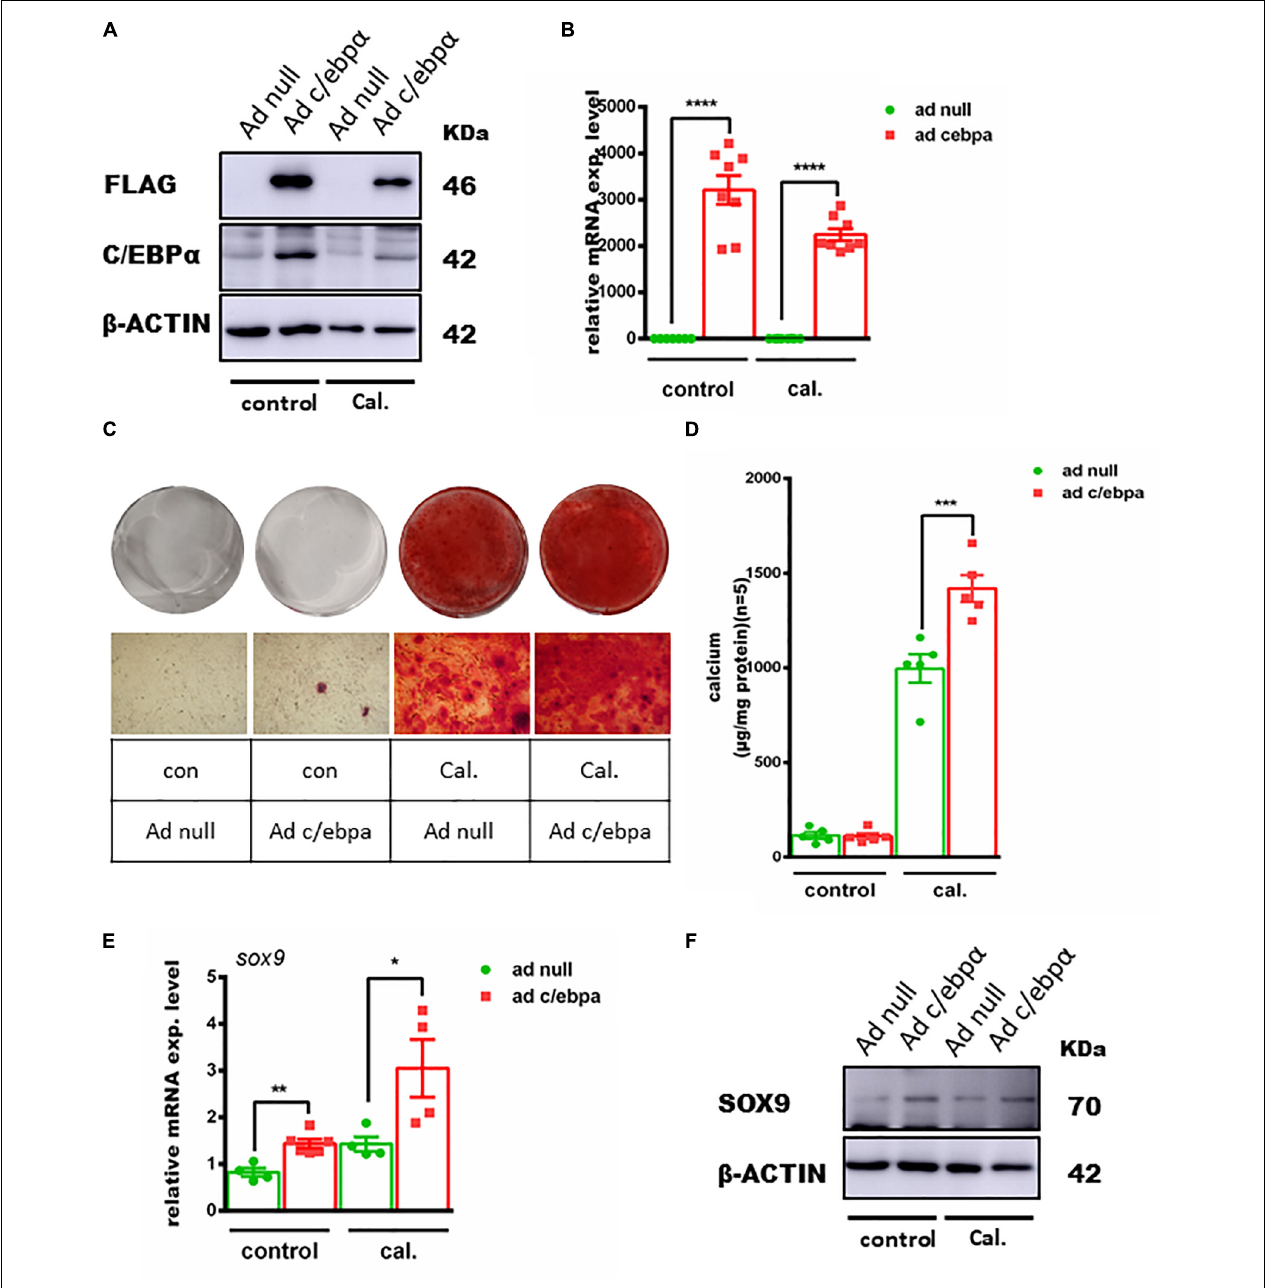
FIGURE 4 | Overexpression of the c/ebp α enhanced calcium-/phosphate-induced VC through upregulating SOX9. (A) Western blotting of VSMCs incubated with Ad-null or Ad-c/ebp α at an MOI of 50 treated with calcium/phosphate or control medium for the c/ebp α protein. (B) Real-time PCR analysis for c/ebp α mRNA expression in VSMCs for the indicated experimental groups. The target mRNAs were normalized to β -actin mRNA and are graphed ( n = 8). (C) Typical images of alizarin red staining confirmed calcium deposition in VSMCs for the indicated experimental groups. Typical areas at 10 × magnifications are placed beside the respective panels. (D) Quantitative calcium assay for VSMCs for the indicated experimental groups ( n = 5). (E) Real-time PCR analysis for sox9 mRNA expression in VSMCs for the indicated experimental groups. The target mRNAs were normalized to β -actin mRNA and are graphed ( n = 4–8). (F) Western blotting of SOX9 in VSMCs for the indicated experimental groups. * p < 0.05, ** p < 0.01, *** p < 0.001, **** p <